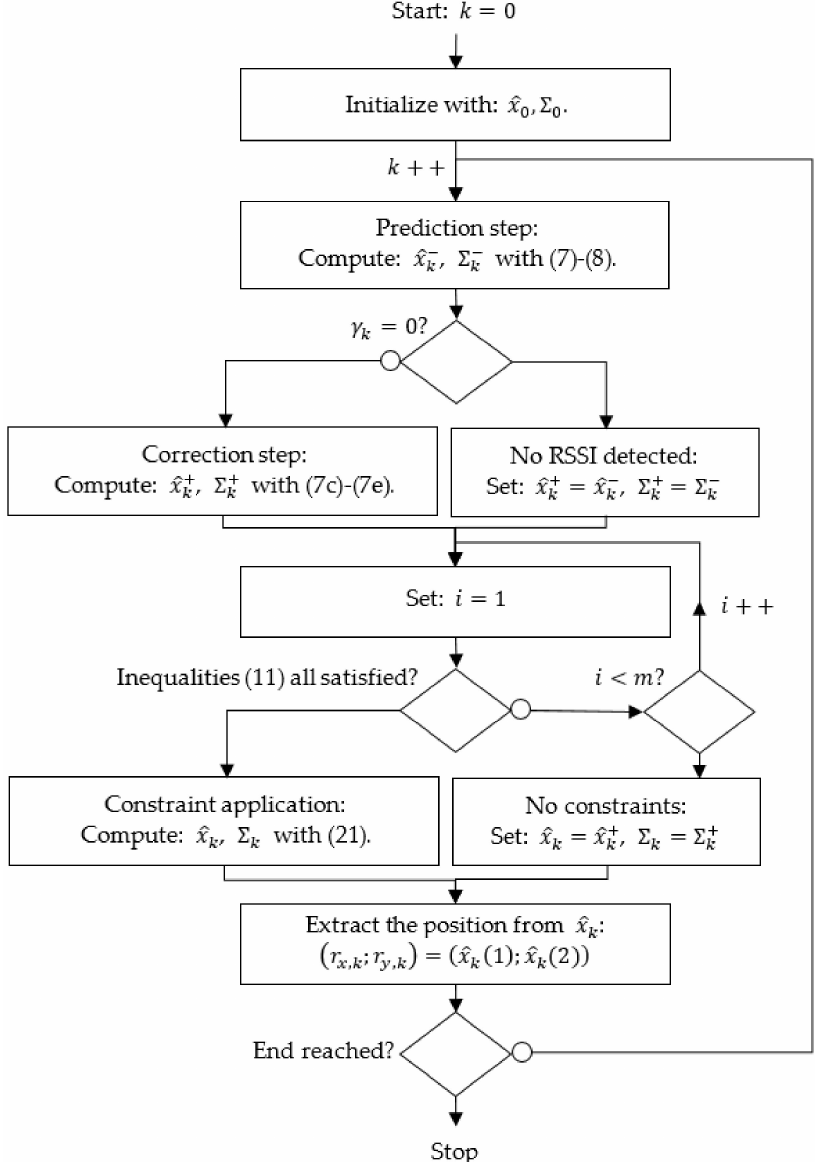
Figure 3. Flowchart of the proposed constrained LBS